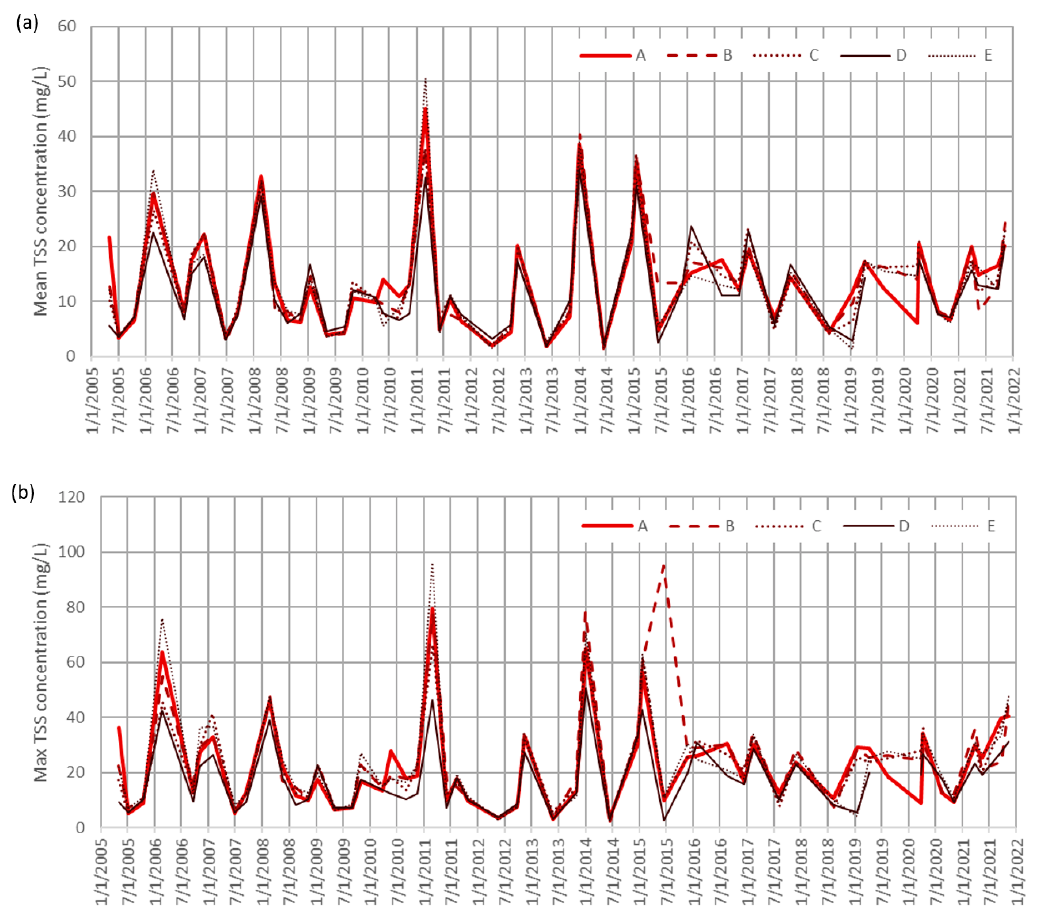
Figure 9. Seasonal variation of ( a ) mean and ( b ) maximum TSS concentration in the five oyster- growing areas (A–E in Figure 2).